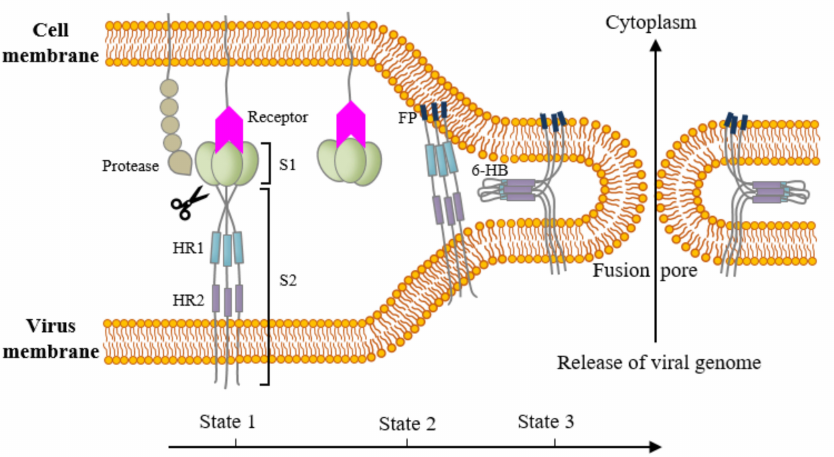
Figure 3. Schematic model for membrane fusion between coronavirus particles and host cells. State 1 (native): the S1 domain is associated with the S2 domain. The fusion peptide (FP) is buried inside the structure and both of the heptad repeats (HRs) exist as trimers individually. State 2 (intermediate state): the S1 domain is dissociated from the S2 domain after receptor binding. Proteolytic cleavage at the S1/S2 boundary and/or at the S2 (cid:48) site helps the FP expose and then insert into the cell membrane. State 3 (fusion active state): HR2 folds back to HR1 and forms a stable six-helix bundle, which brings viral and cellular membranes into close proximity, forming a fusion pore, which is followed by releasing viral genome into the cytoplasm of host cells. FP: fusion peptide. HR1: heptad repeat 1. HR2: heptad repeat 2. 6-HB: 6-helix